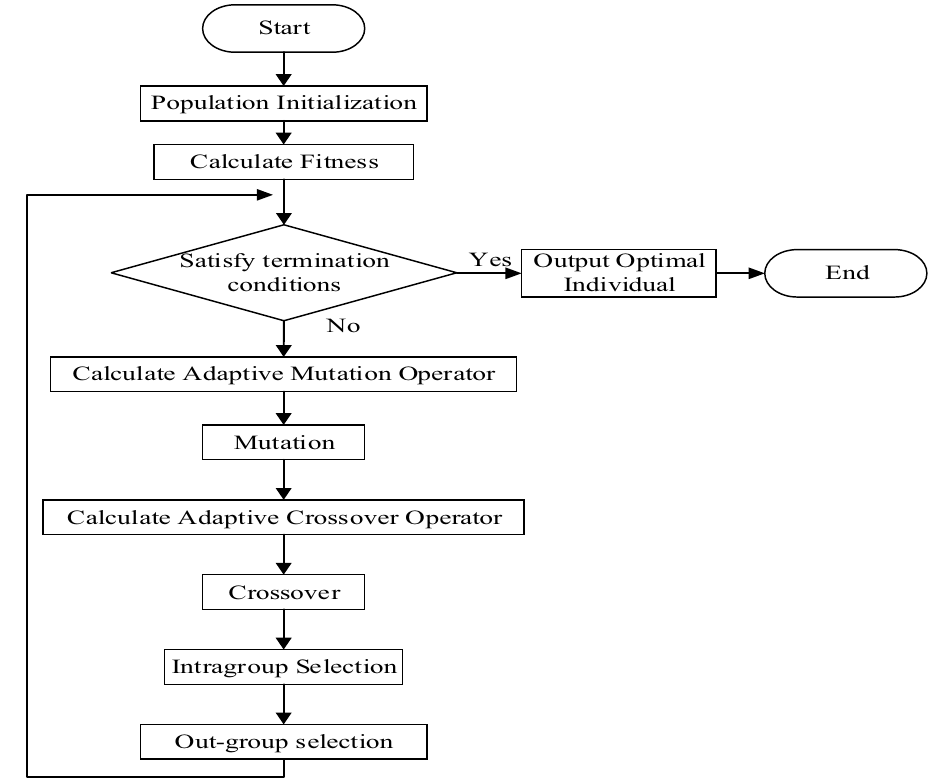
Fig. 3 Flow chart of improved differential evolution